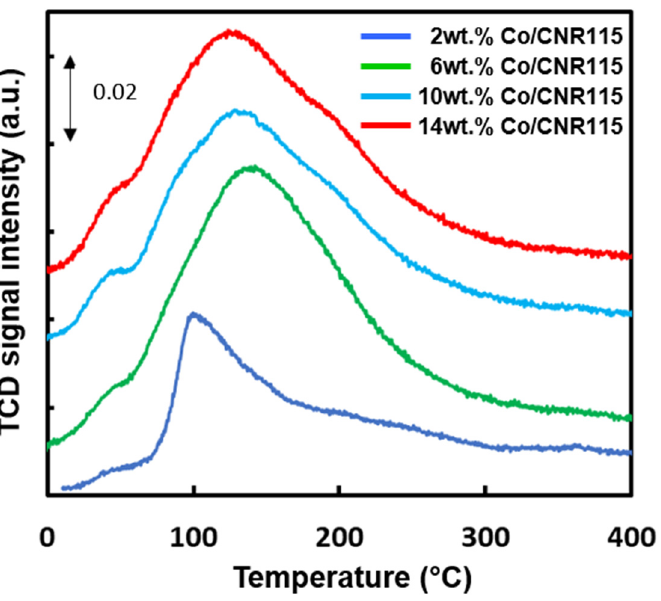
Figure 4. Temperature-programmed desorption of hydrogen (H 2 -TPD) profiles for catalysts with different cobalt loading.